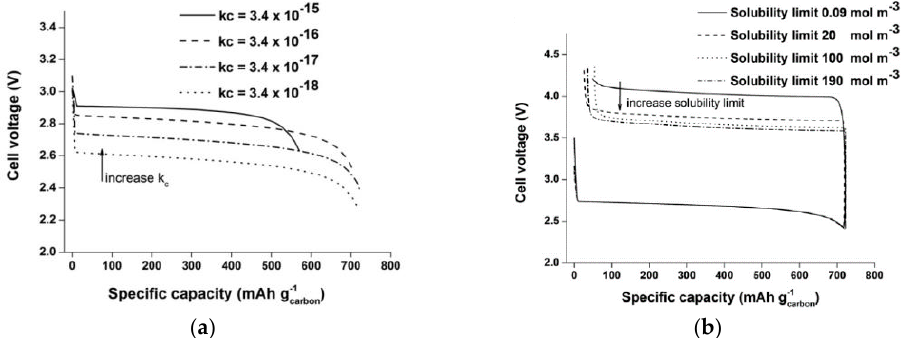
Figure 26. Predicted cell performance of the Li-air battery at a current density of 0.1 mA/cm 2 as a function of ( a ) cathodic rate constant and ( b ) Li 2 O 2 solubility factor. Reprinted from Sahapatsombut et al. [10] , with permission from Elsevier.